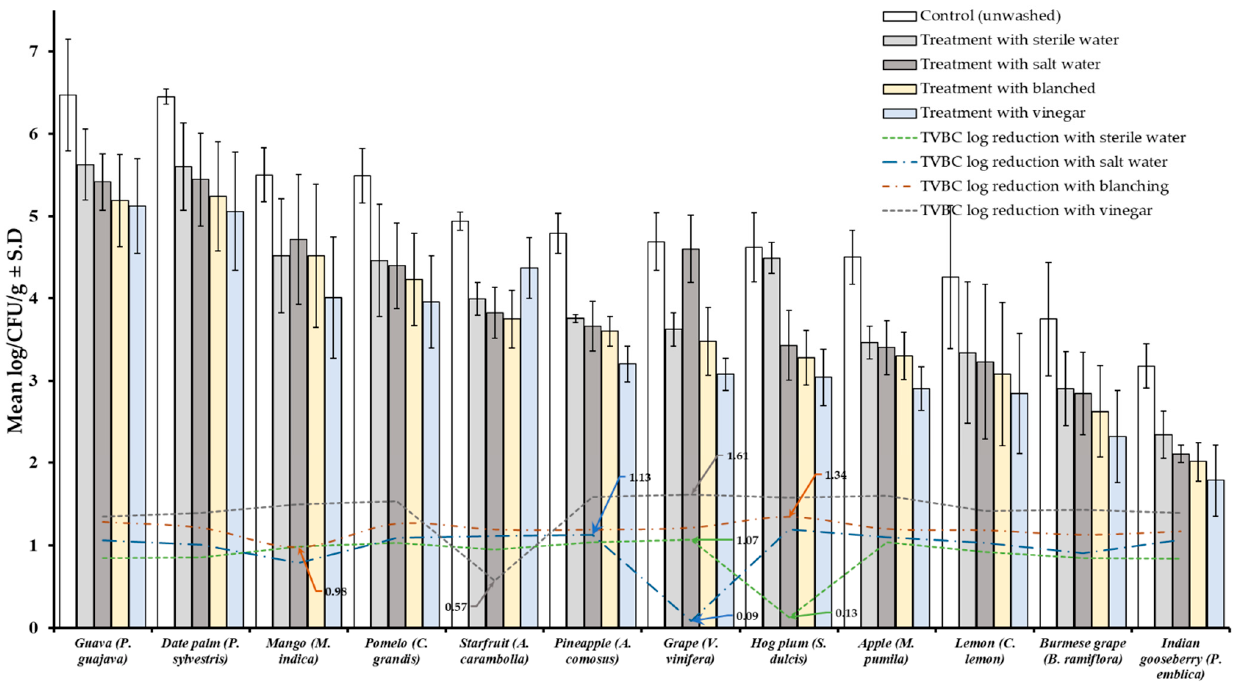
Figure 2. Four different treatments (sterile water, salt solution, blanched, and vinegar) were observed on total viable bacterial load (TVBC) decontamination from the surface of 12 different types of fruit. Data are mean ( n = 4) ± standard deviation.